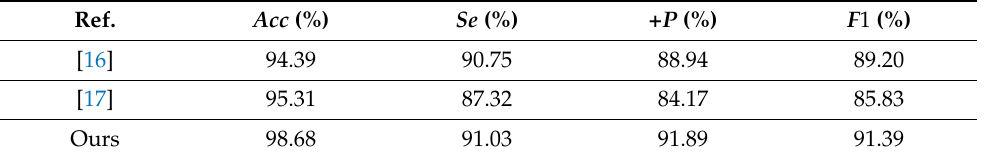
Table 8. The performance comparison on the CPPDB.